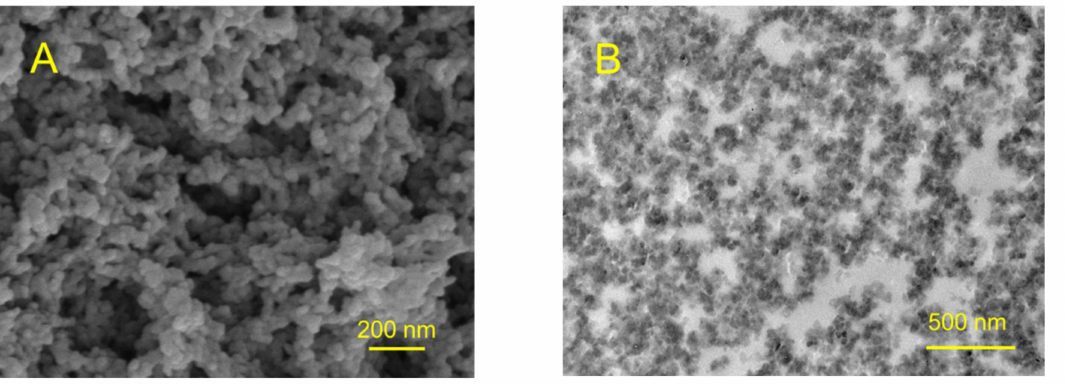
Figure 7. SEM image of the surface morphology of synthesized polymer ( A ) and TEM image of ultrathin cut of the synthesized polymer ( B